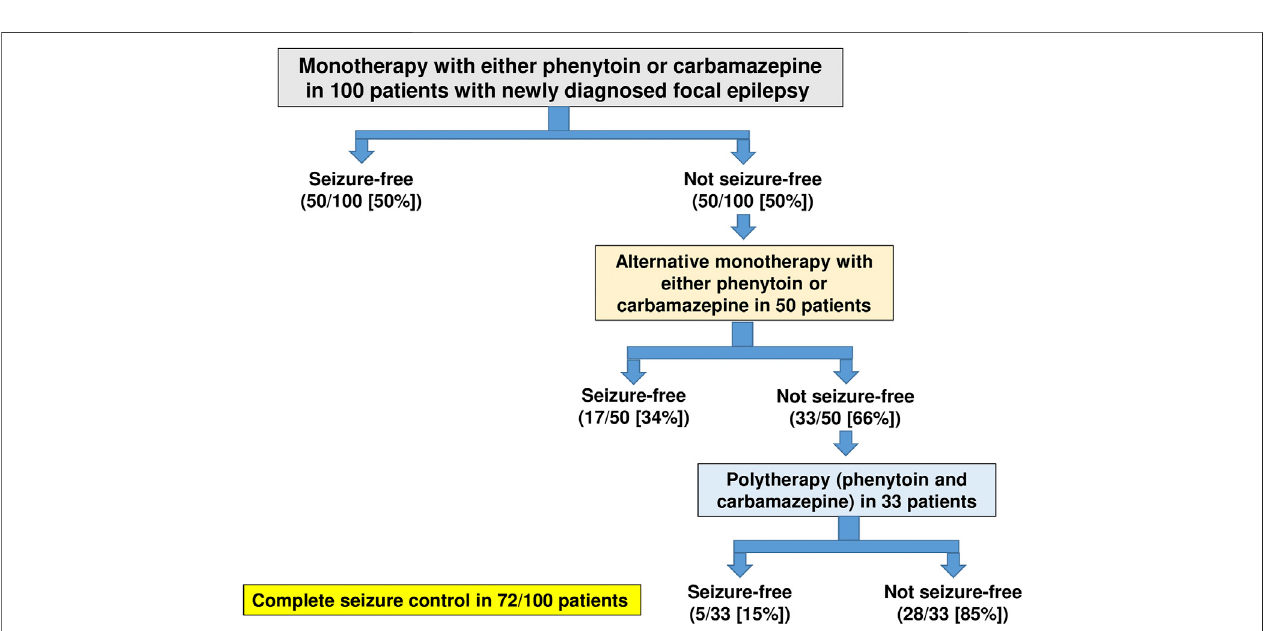
FIGURE3| Summaryoftheef fi cacyofmonotherapy(withphenytoinorcarbamazepine),alternativemonotherapy(withthealternativeagent),andpolytherapy(with bothagents)in100adultpatientswithnewlydiagnosedfocalepilepsy.Successwasde fi nedascompleteseizurecontrol.Dataarefromarandomized,nonblindedtrialin adult patients with newly diagnosed partial epilepsy (Hakkarainen, 1980).